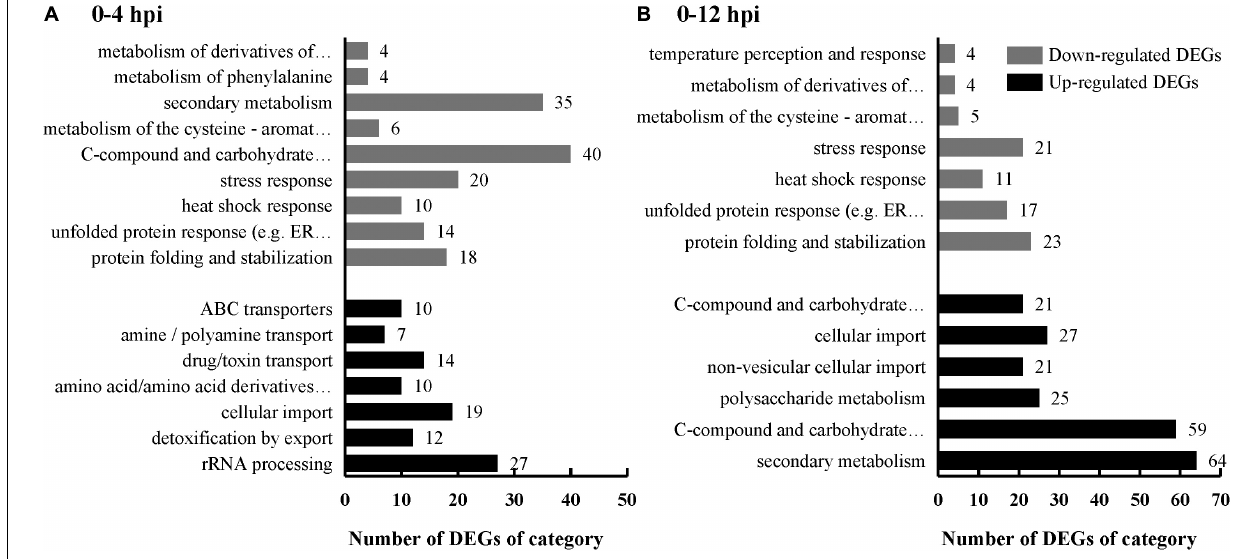
FIGURE 3 | FunCat category enrichment of S. sclerotiorum DEGs induced by C. minitans . Genes were analysized according to the web-based FungiFun2 database against genome of S. sclerotiorum . X-axis represents the DEG number of a functional category. Black bars represent the up-regulated DEGs and gray bars represent the down-regulated DEGs. (A) S. sclerotiorum DEGs in 0–4 hpi. (B) S. sclerotiorum DEGs in 0–12 hpi. The detailed information was shown in Supplementary Table S3